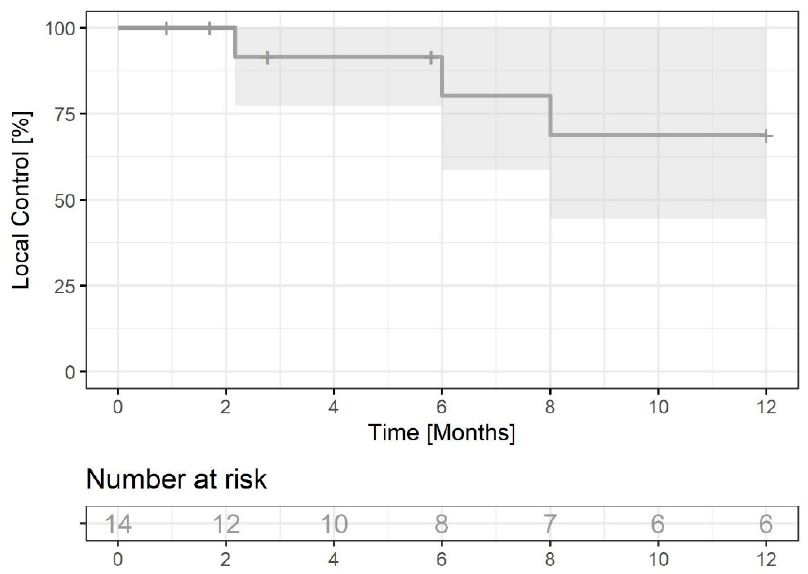
Figure 4. Local control in the brain (n = 14) in the group of patients with brain metastases (excluding those with bone and meningeal metastases only). Grey field indicates 95%